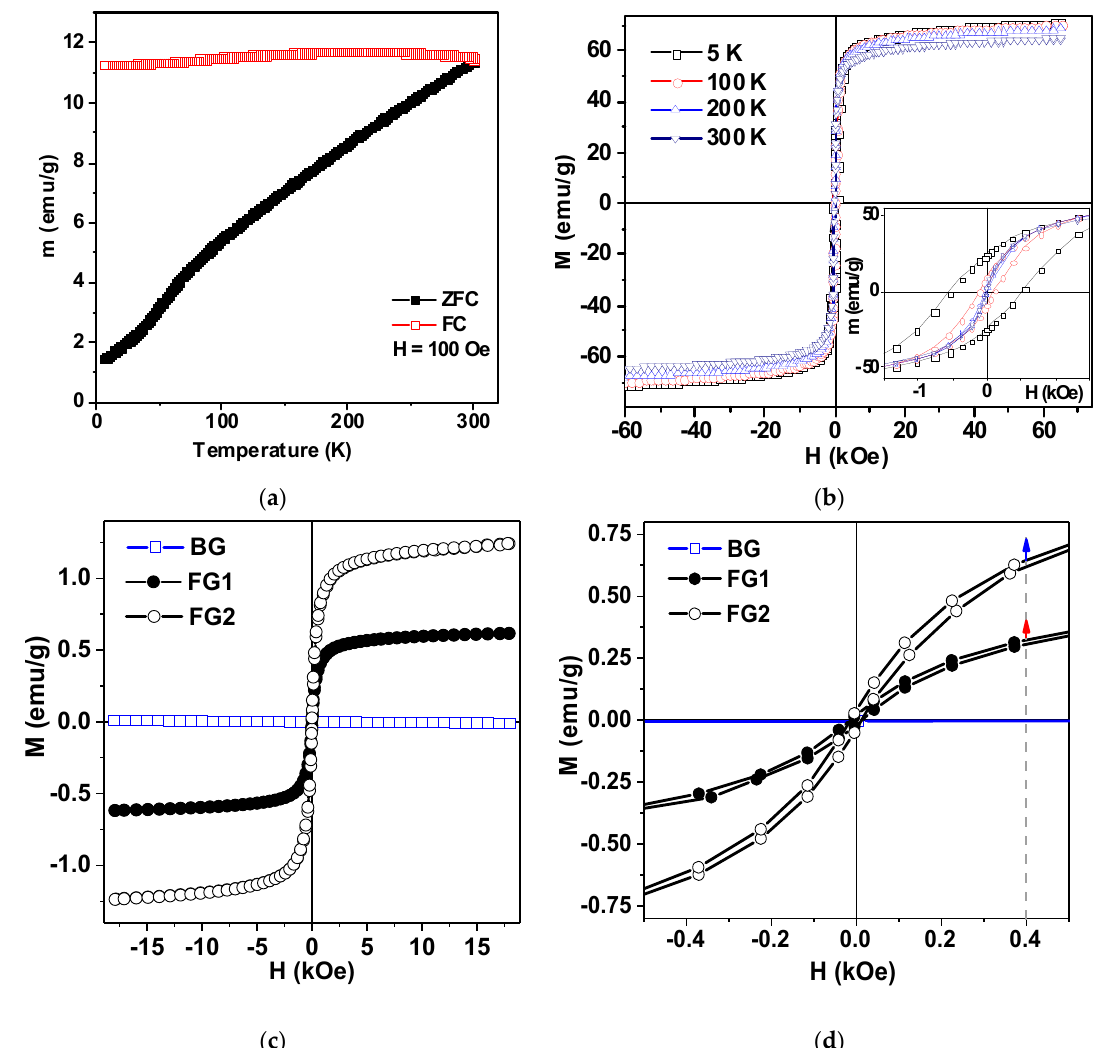
Figure 7. ( a ) Zero-field cooled and field cooled (ZFC-FC) thermomagnetic curves of air-dry laser target evaporation (LTE) iron oxide MNPs; ( b ) magnetic hysteresis loops of LTE iron oxide MNPs measured for fixed selected temperatures; ( c ) magnetic hysteresis loops of blank gel (BG) and ferrogels FG1 and FG2; ( d ) magnetic hysteresis loops of blank gel and ferrogels in the low-fields region. Dashed line indicates external magnetic field strength of 400 Oe, i.e., typical field strength created by magnetic system in the experiments with cell cultures. Blue arrow indicates maximum value of saturation magnetization for FG2 and red arrow indicates maximum value of saturation magnetization for